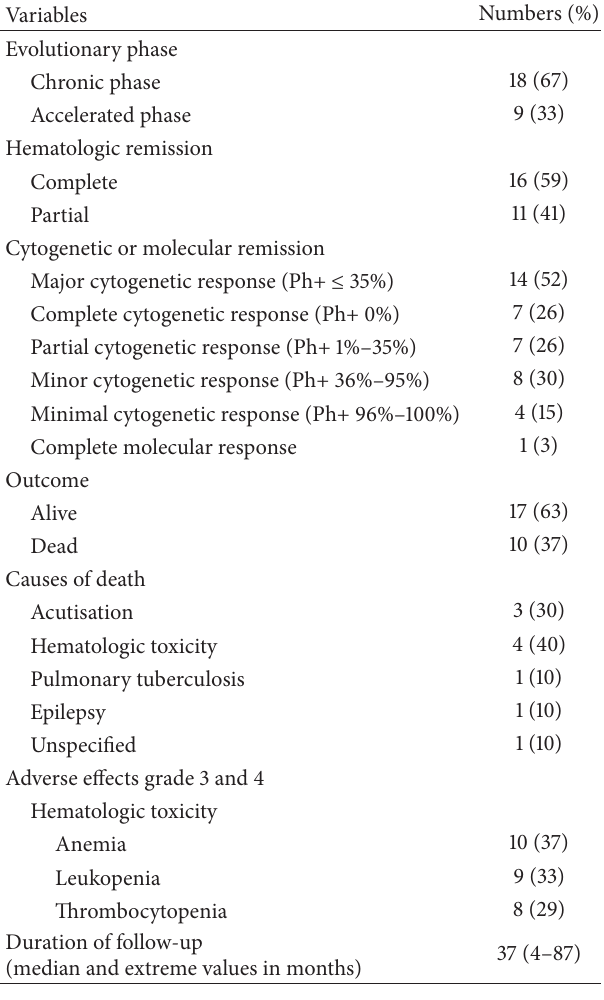
Table 3: Therapeutic and evolutionary